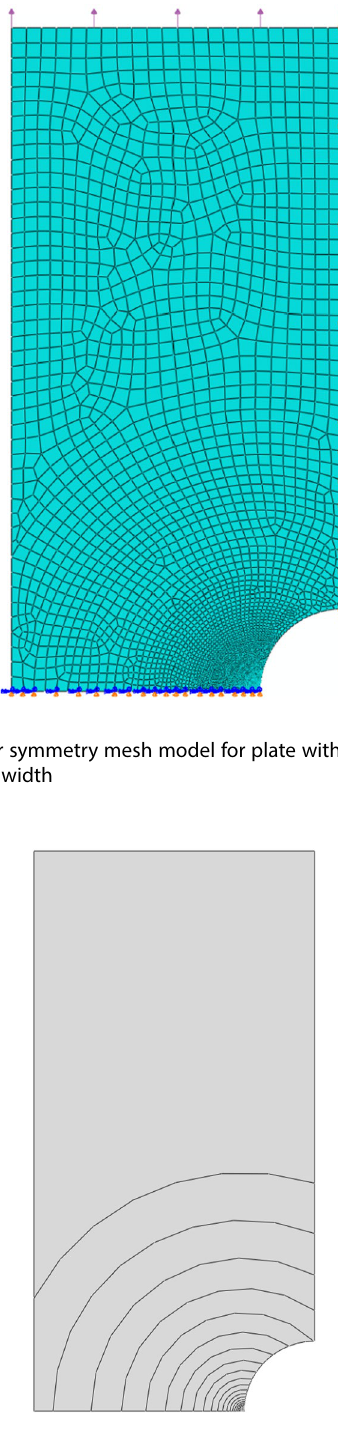
Fig. 4 Radial layers emanating from crack opening